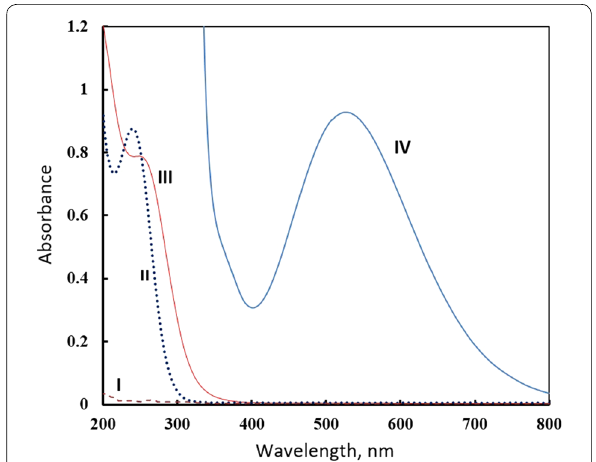
Fig. 3 Absorption spectra of (I) etidronate (1 (2 10 − 4 M ), and (III) FeCl 3 (2 × all in 2 M perchloric in addition to (IV) the absorption Spectrum